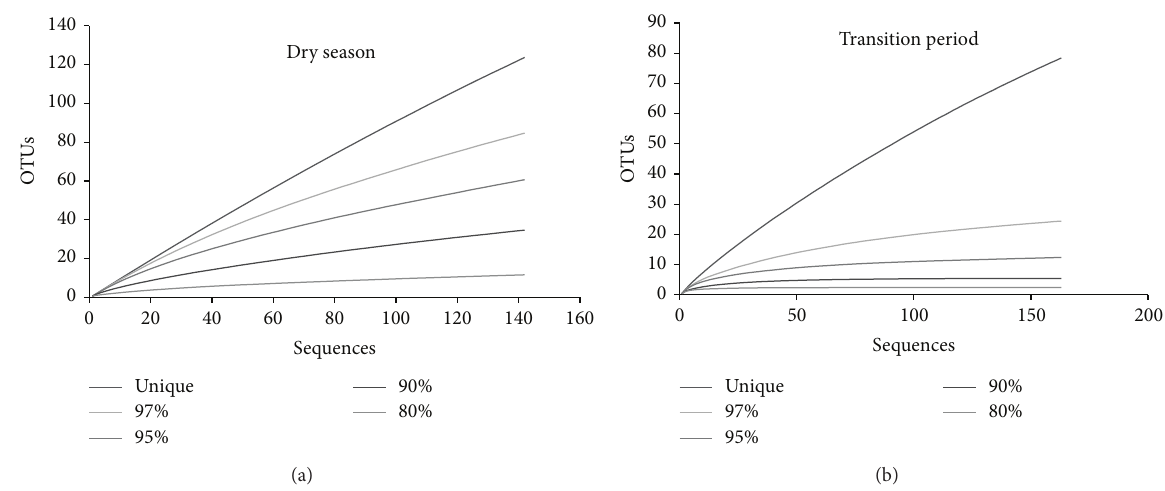
Figure 1: Rarefaction curves for archaeal 16S rRNA gene sequences from Cerrado freshwater lake sediments at different sequence identity of sequences obtained in the dry season (a) and in the transition period (b). Curves were obtained using the Mothur software.